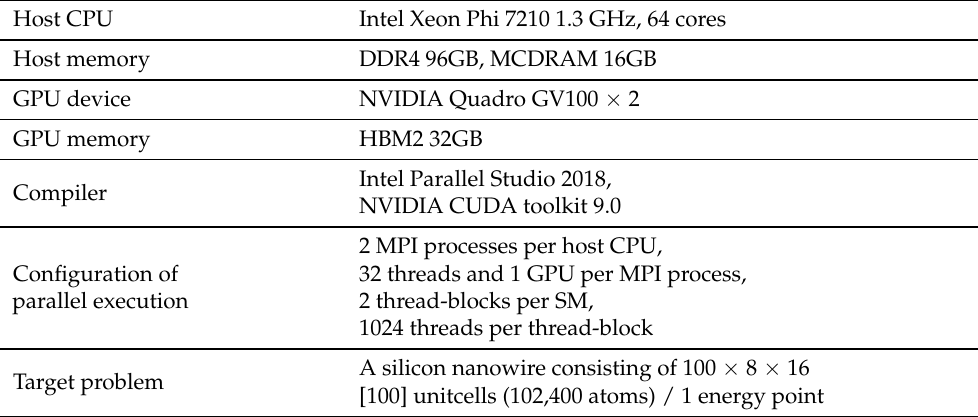
Table 2. Computing environment for single-node performance